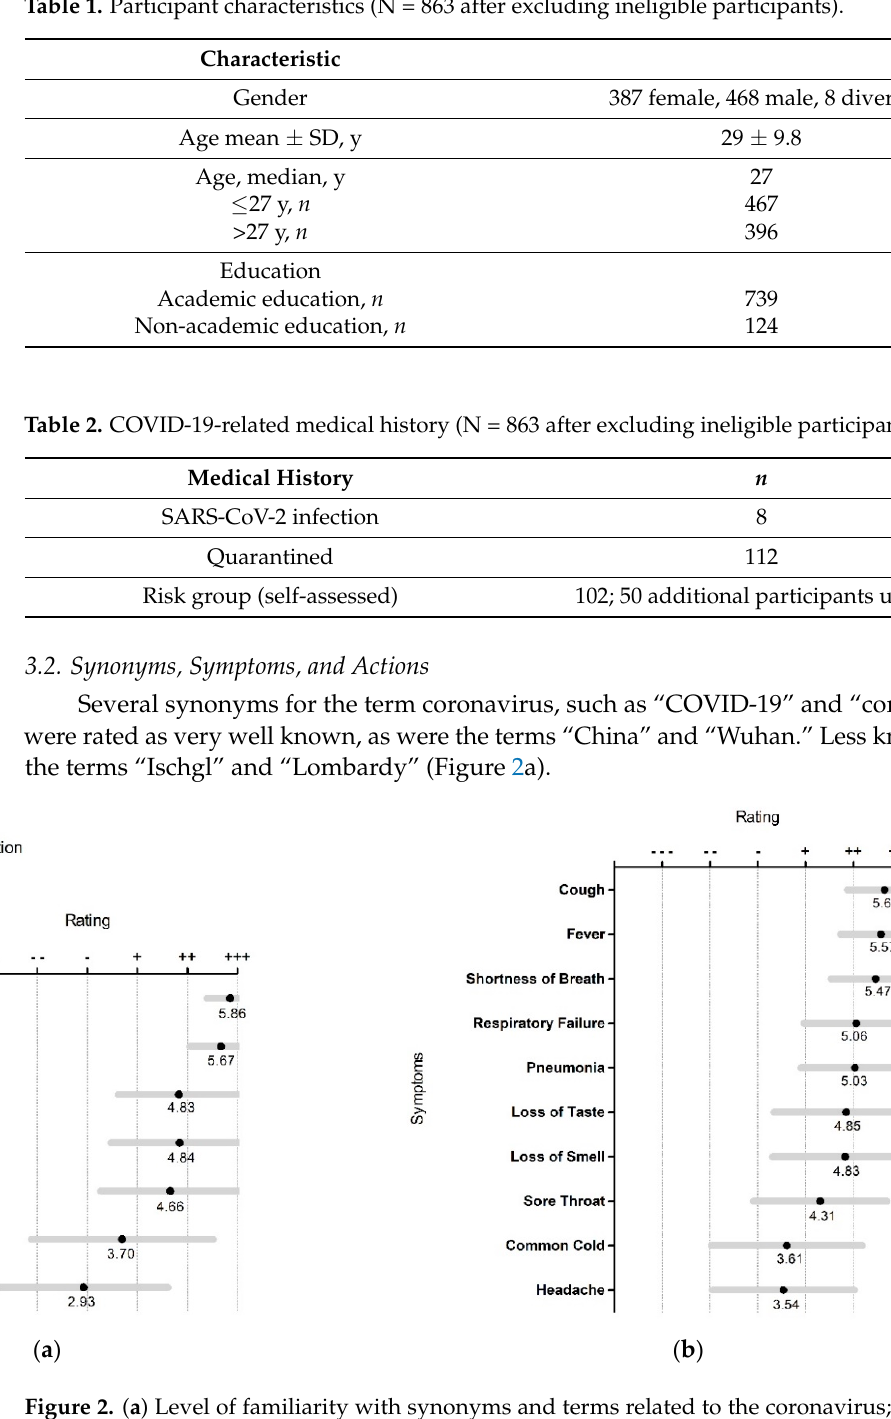
Table 1. Participant characteristics (N = 863 after excluding ineligible participants).